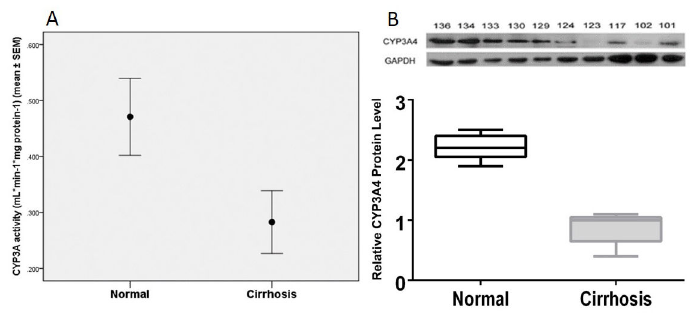
Figure 1. Cytochrome P450 3A activity and protein expression in cirrhosis and normal liver tissue samples. ( A ) Decreased CYP3A activity as determined by the intrinsic clearance based on formation of 1’-OH midazolam formation in cirrhosis and normal liver tissue samples. ( B ) CYP3A4 protein expression in randomly selected cirrhotic (n=5) and normal liver samples (n=5) detected by western blotting (upper panel). Quantified CYP3A4 expression relative to GAPDH was shown as well (bottom panel). Experiments were repeated twice and the representative sample was